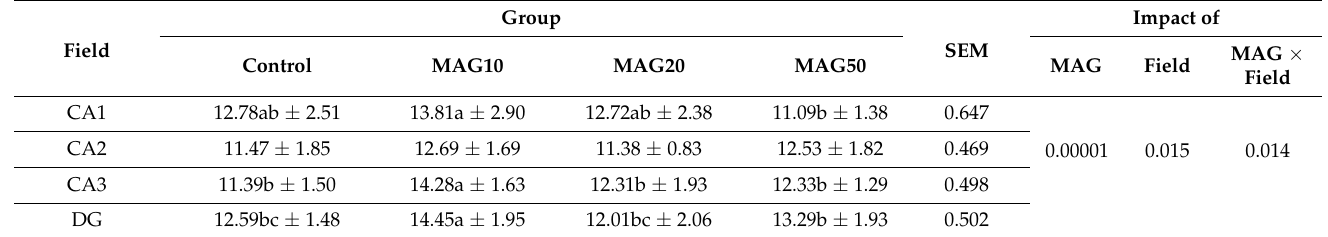
Figure 8. Differences in the average number of PV-IR neurons (blue line) and PV-IR nerve fibers (red line) depending on the dose of magnoflorine in different fields (CA1, CA2, and CA3) and the DG. The data are expressed as means; A, B, C, D—the different capital letters indicate significant differences at p ≤ 0.01 between the average number of neurons depending on the magnoflorine dose in each analyzed field; a, b, c, d—the different lower-case letters indicate significant differences at p ≤ 0.01 between the average number of PV-IR nerve fibers depending on the magnoflorine dose in each analyzed field; n = 5. Table 1. The average sizes of PV-IR neurons depending on the the magnoflorine doses (10, 20 and 50 mg) in each investigated field (CA1, CA2, and CA3) and the DG. The data are expressed as means ± SD (standard deviation); a–c—the different letters indicate significant differences at p ≤ 0.01 between the average neuron size depending on the magnoflorine dose in each field; n =